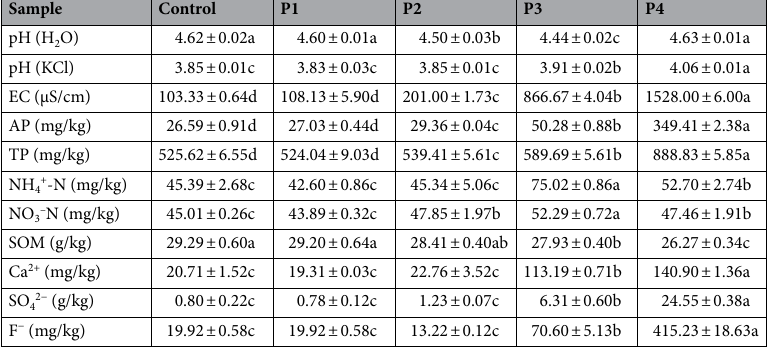
Table 1. Soil properties under different treatments. Different lowercase letters stand for significant differences at the level of P < 0.05. Control: no PG was applied; P1: 0.01% PG; P2: 0.1% PG; P3: 1% PG; P4: 10% PG.